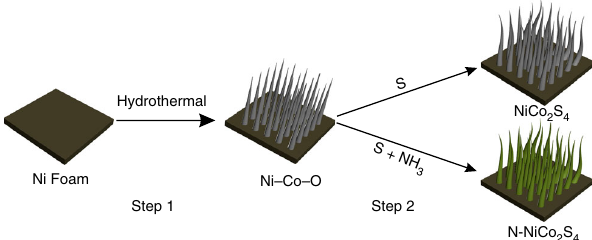
Fig. 1 Schematic illustration of the fabrication of NiCo 2 S 4 and N – NiCo 2 S 4 nanowires through a two-step synthesis. Step 1: hydrothermal synthesis of Ni – Co – O nanowire arrays. Step 2: sulfurization and nitridation of Ni – Co – O to prepare NiCo 2 S 4 and N – NiCo 2 S 4 nanowire